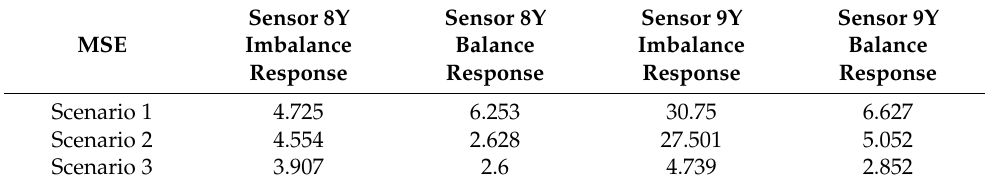
Table 8. Decomposed function parameters identified by DE algorithm. Function parameters in imbalance and healthy condition. The MD3 scenario selection number is highlighted in bold font.